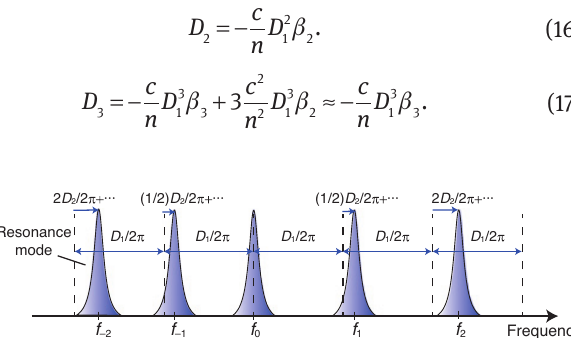
), 2 ), and silicon 2